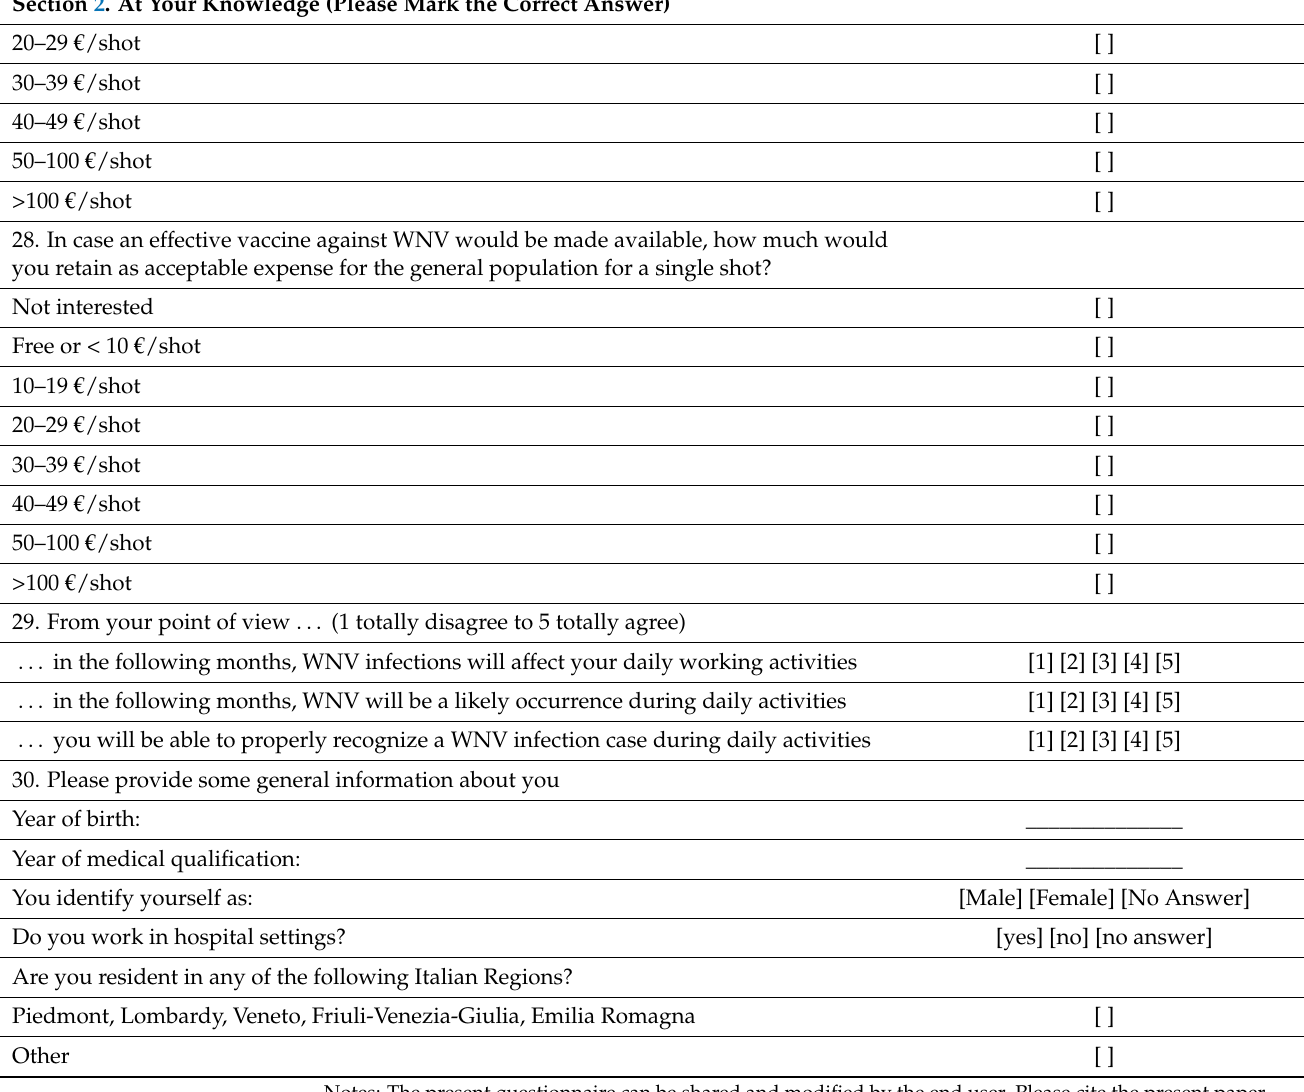
Table A2. Knowledge test: summary of the answers on presented items proposed to the 254